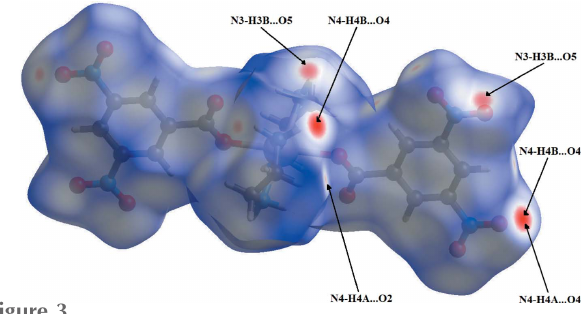
Figure 3 View of the three-dimensional Hirshfeld surface of the title compound plotted over d norm in the range (cid:3) 0.2200 to 1.2846